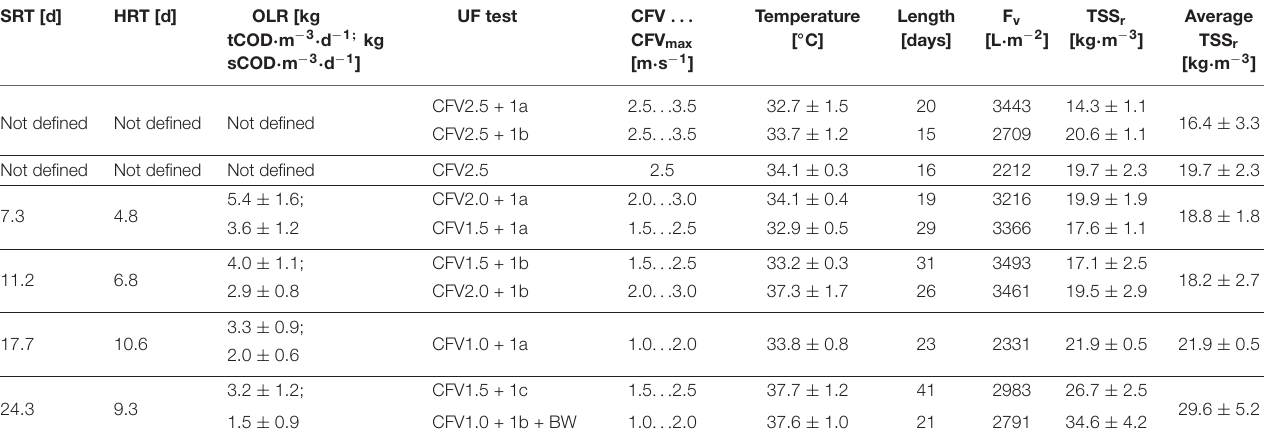
TABLE 3 | Operational conditions utilized in the bioreactor during AnMBR operation. SRT [d]